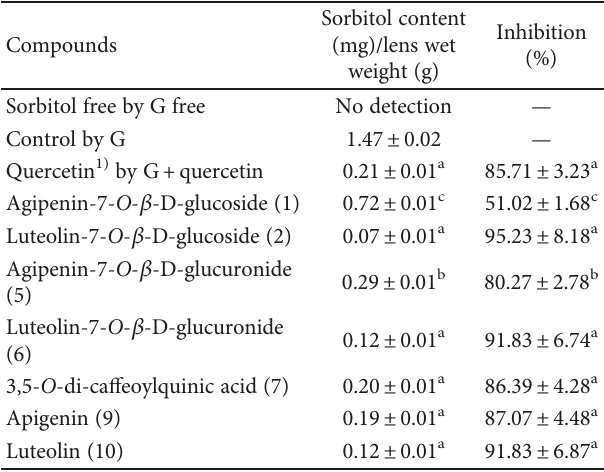
Table 3: Inhibitory e ff ects of rat lens aldose reductase-active compounds of Matricaria recutita L. on sorbitol accumulation in rat